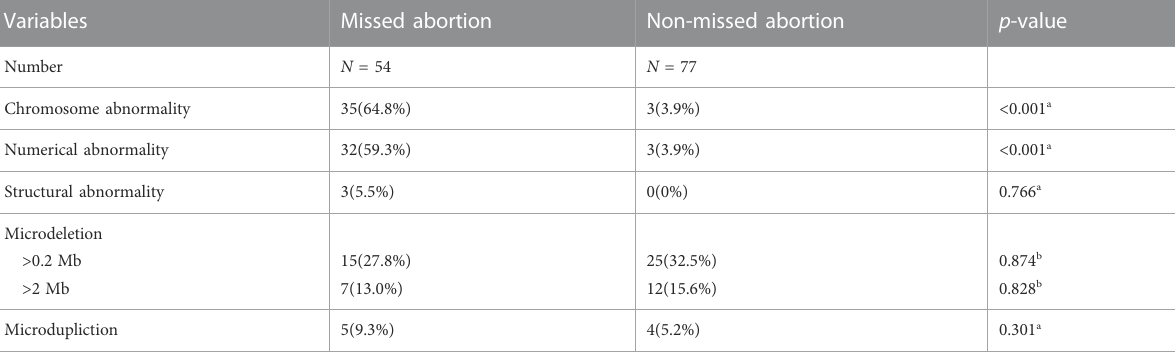
TABLE 3 Description of the chromosome of villi by type of